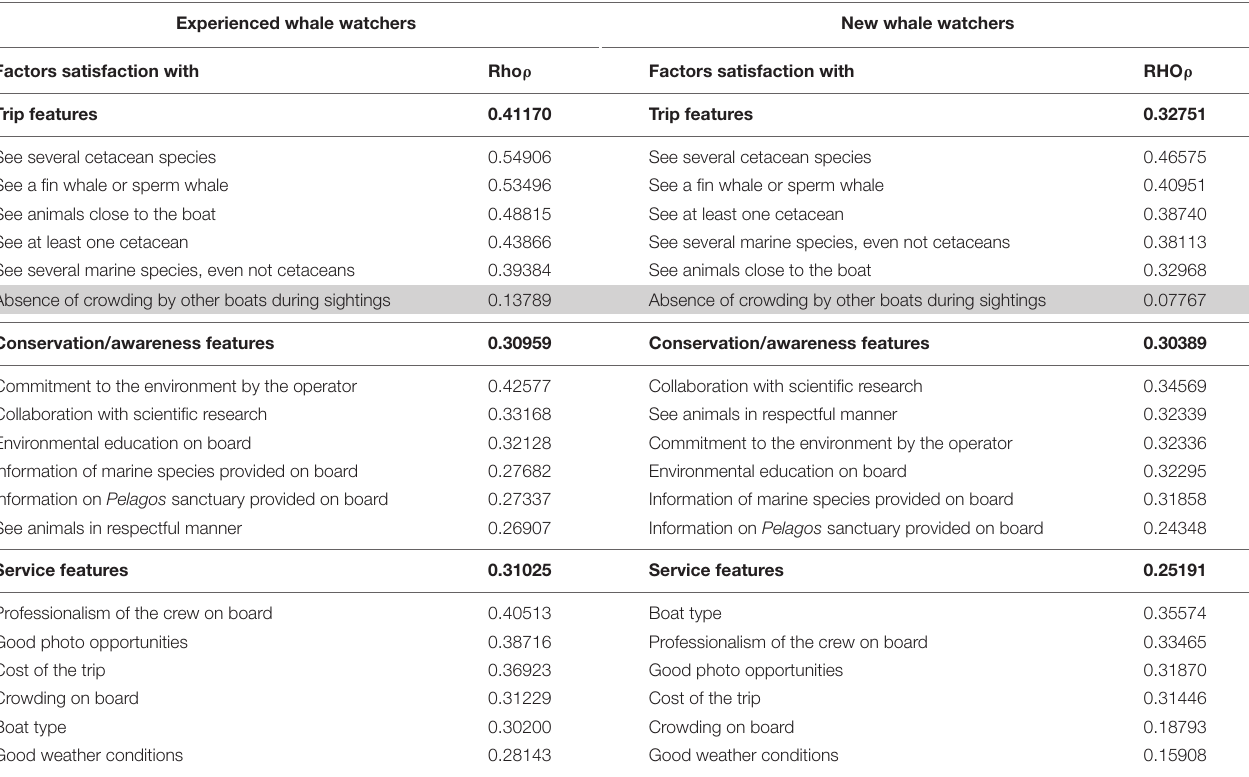
TABLE 4 | Factors affecting satisfaction, separately for the two